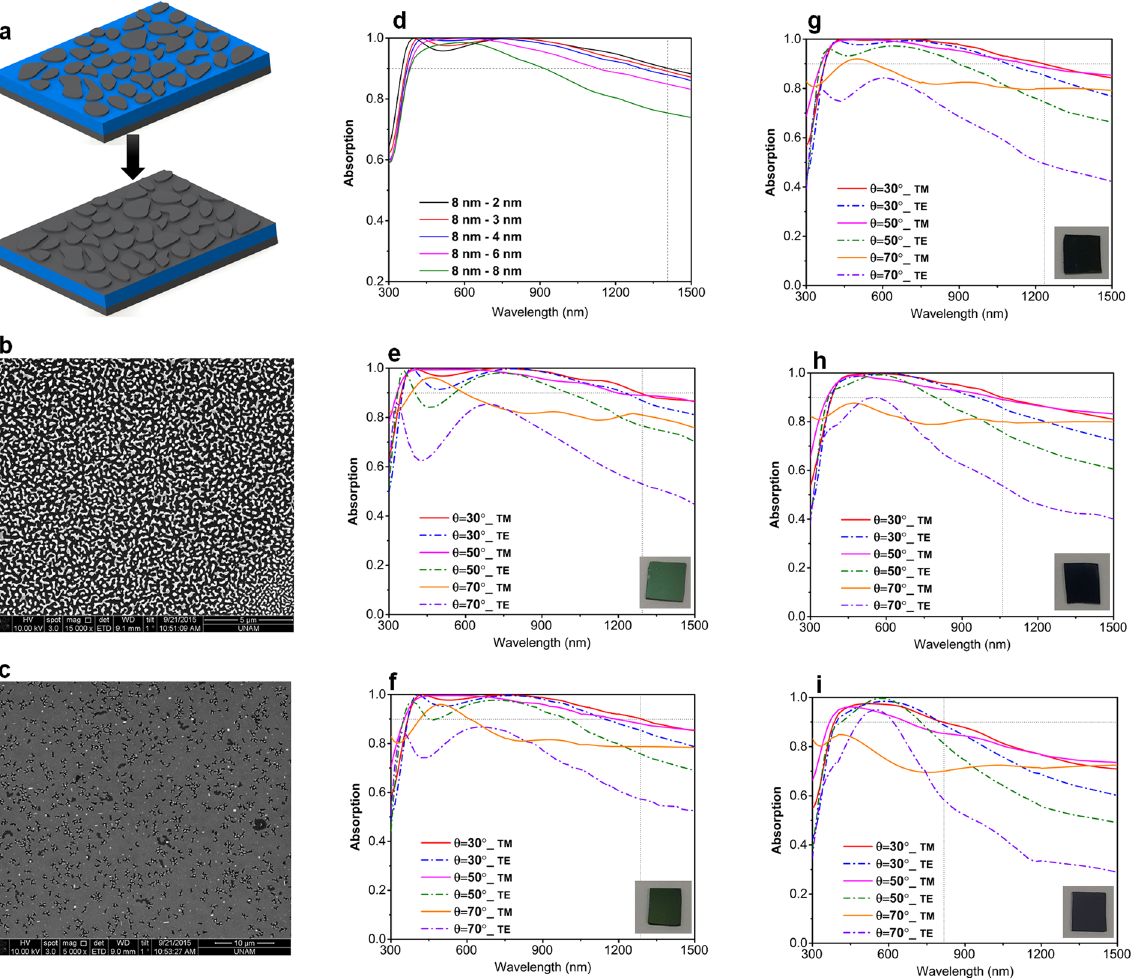
Figure 7. The proposed approach to obtain non-uniform textured configuration using dewetting process and SEM images of ( b ) thin (8 nm) and ( c ) thick (14 nm) Pt layer annealed at 800 °C. ( d ) Absorption spectra of fabricated samples with different configurations for normal incidence excitation. Angular dependence of absorption for different angles of incidence and polarizations (TE and TM) for the cases of ( e ) 8 nm–2